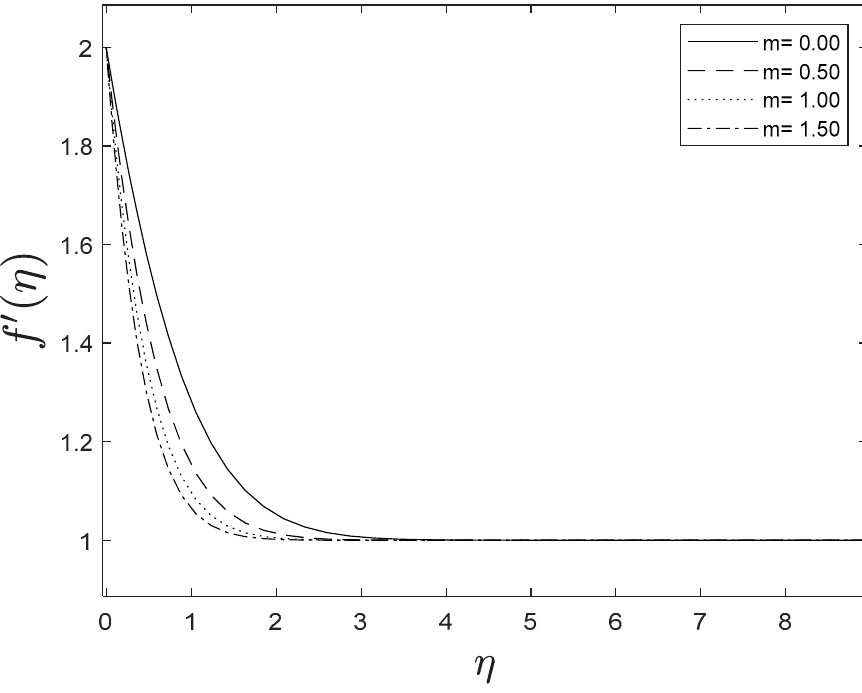
Figure 5. Effect of different values of m on